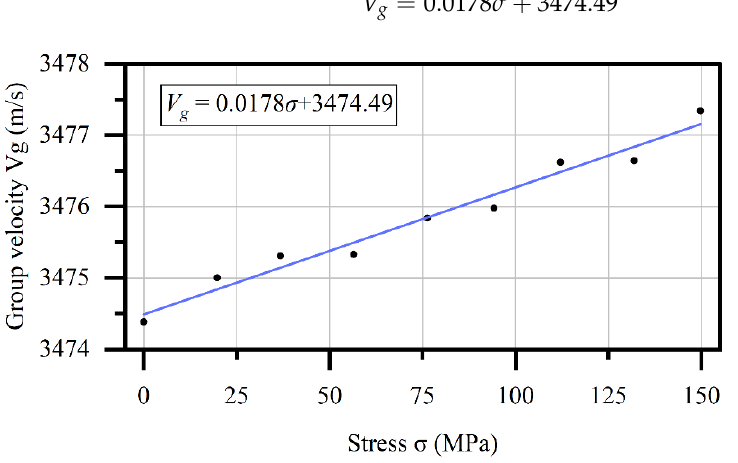
Figure 7. Calibration result of relationship between group velocity and stress.